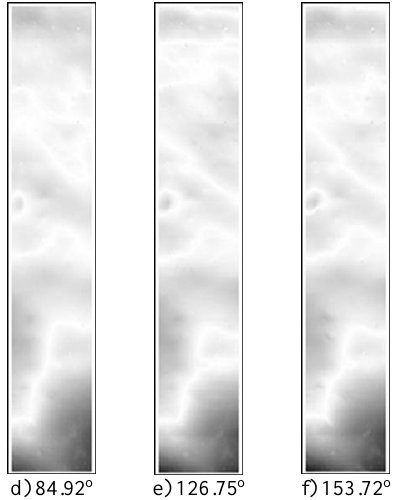
Figure 7. Vertical difference DEMs (1m/pixel) at each illumination azimuthal difference